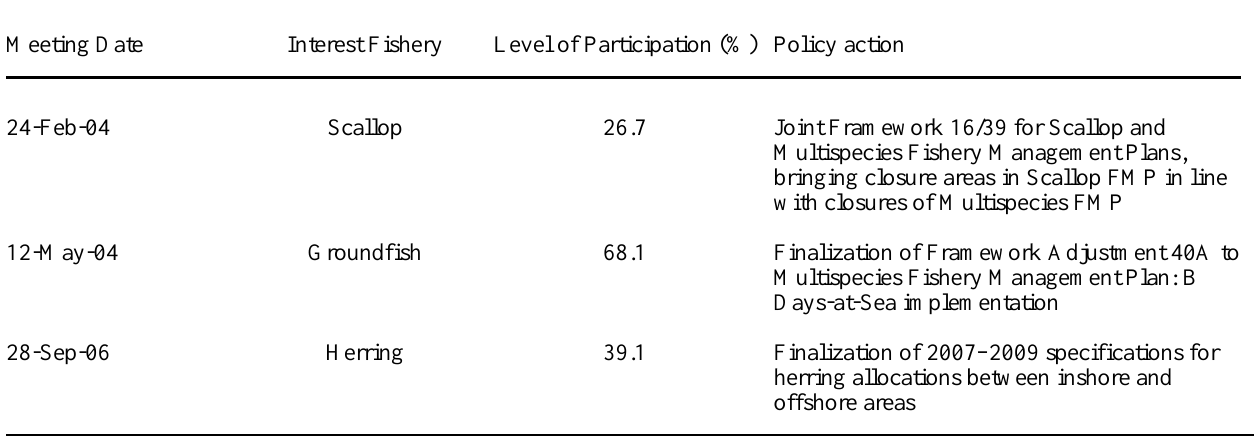
Table 1. Examples of highly attended meetings. One meeting is listed for each focus fishery. Level of participation indicates the percentage of the industry’s attendees compared with the total attendees present at the